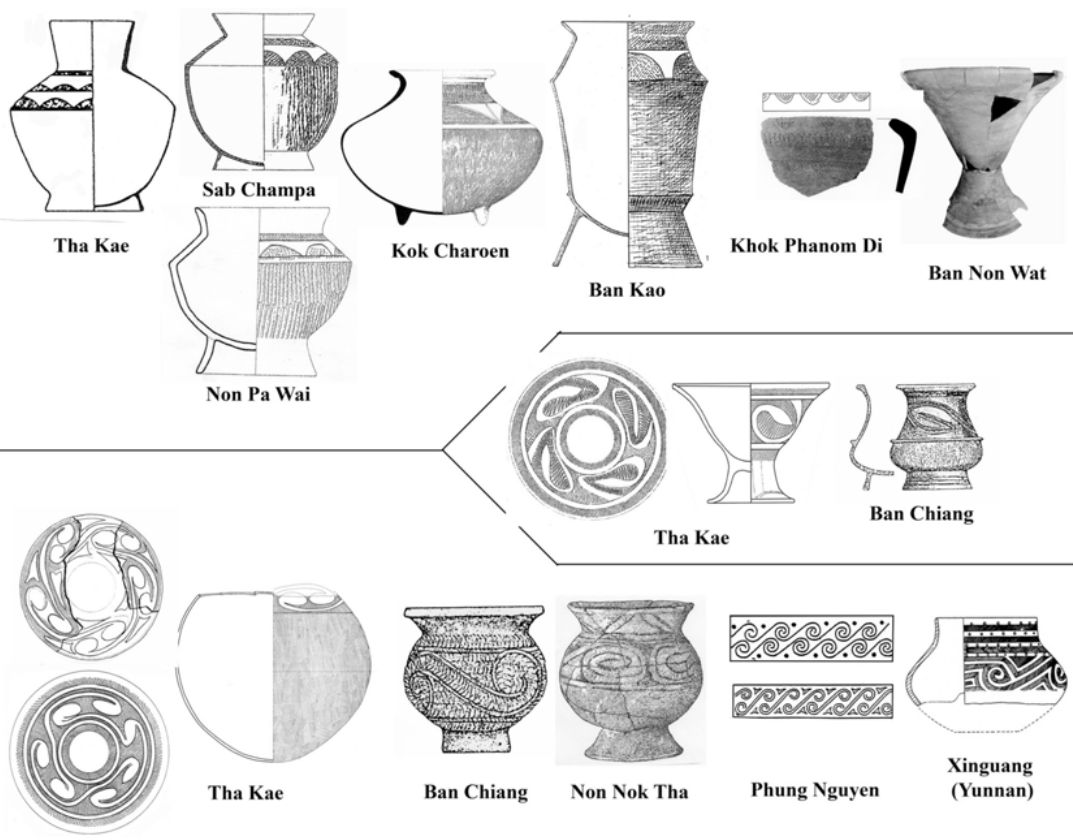
Fig. 5: Motifs impressed and incised on Neolithic ceramic vessels from Southeast Asia and southern